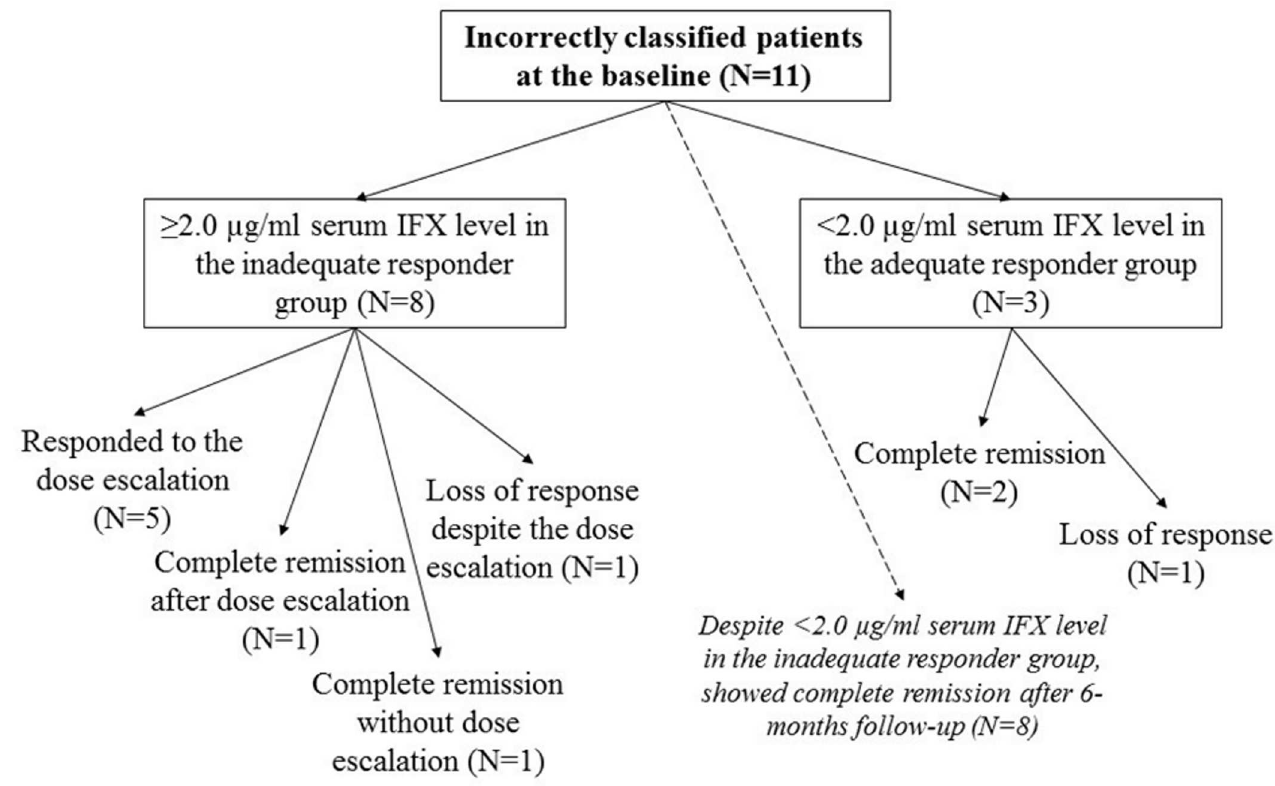
Fig 3. Incorrectly classified casesby serum infliximab trough levels after 6-months follow-up.